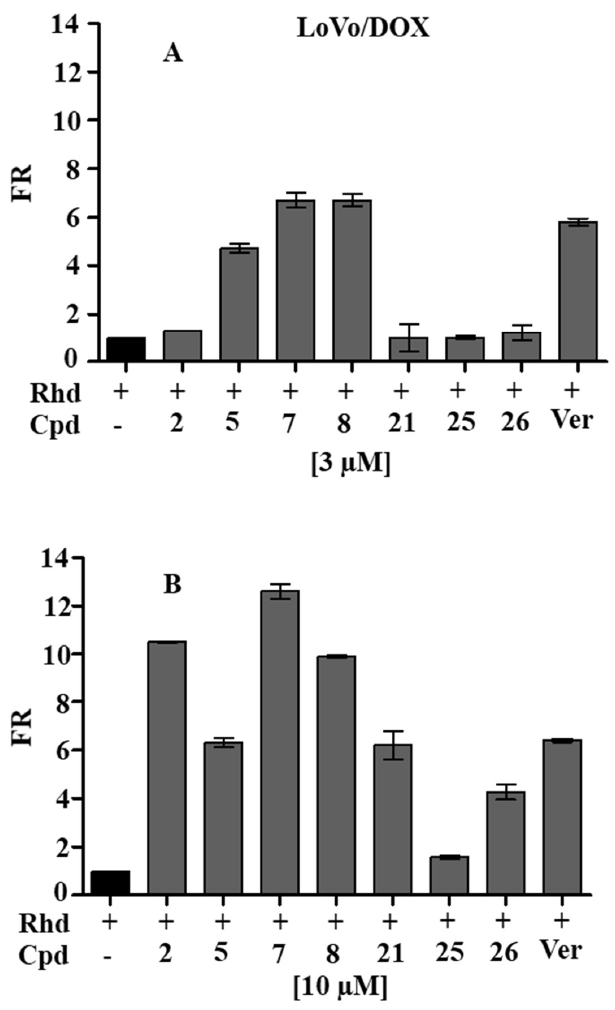
Figure 1. Fluorescence ratio (FR) values in LoVo/DOX cells incubated with rhodamine in the presence and in absence of modulators 2 , 5 , 7 , 8 , 21 , 25 and 26 and verapamil at 3 µM (panel A ) and 10 µM (panel B ) concentrations. Value 1 was attributed to the average fluorescence intensity of the samples exposed only to rhodamine.